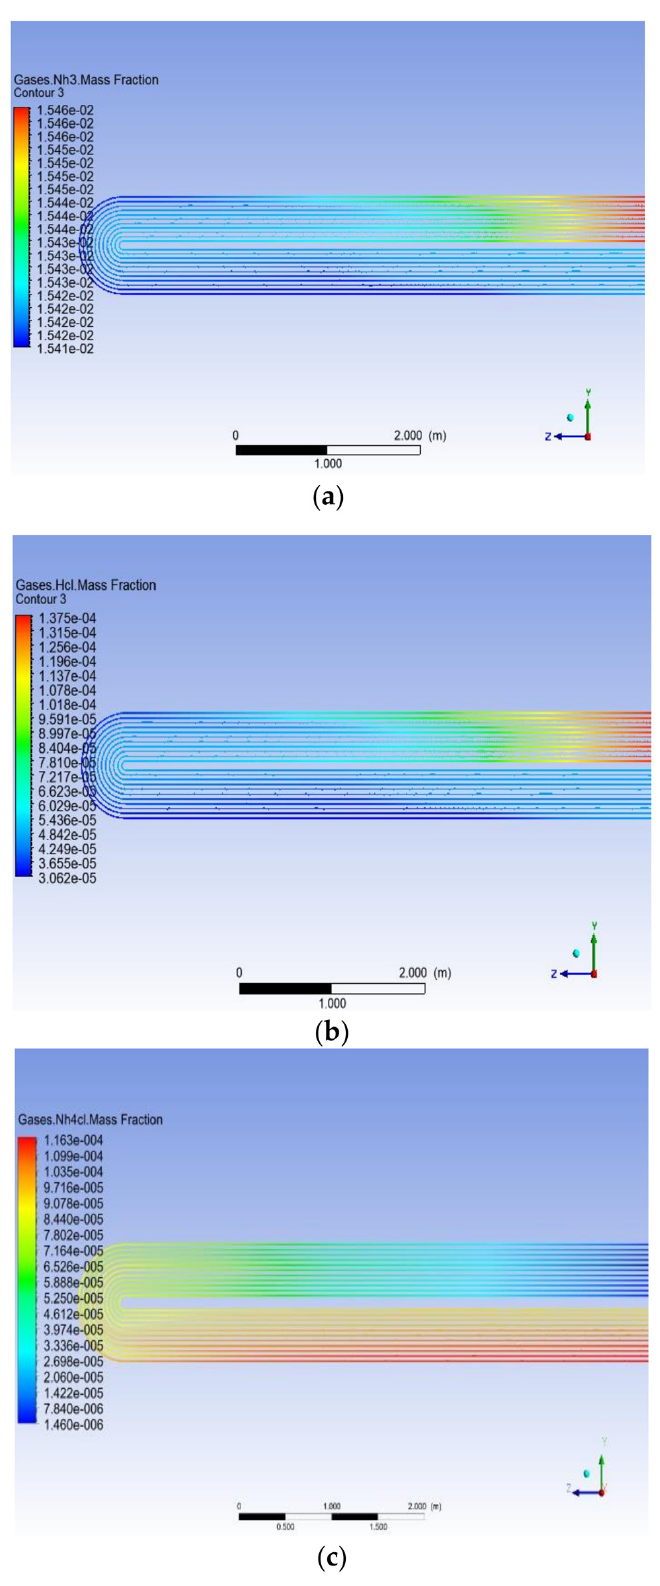
Figure 21. Changes in the content of the components: ( a ) ammonia, ( b ) hydrogen chloride and ( c ) ammonium